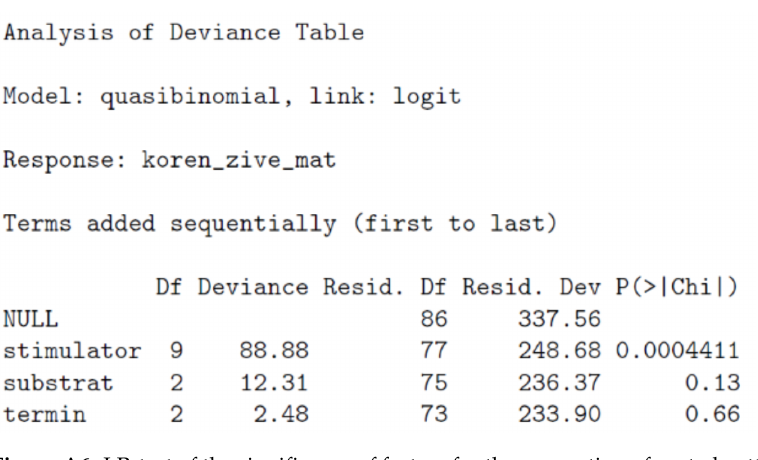
Figure A6. LR-test of the significance of factors for the proportion of rooted cuttings from the number of survived